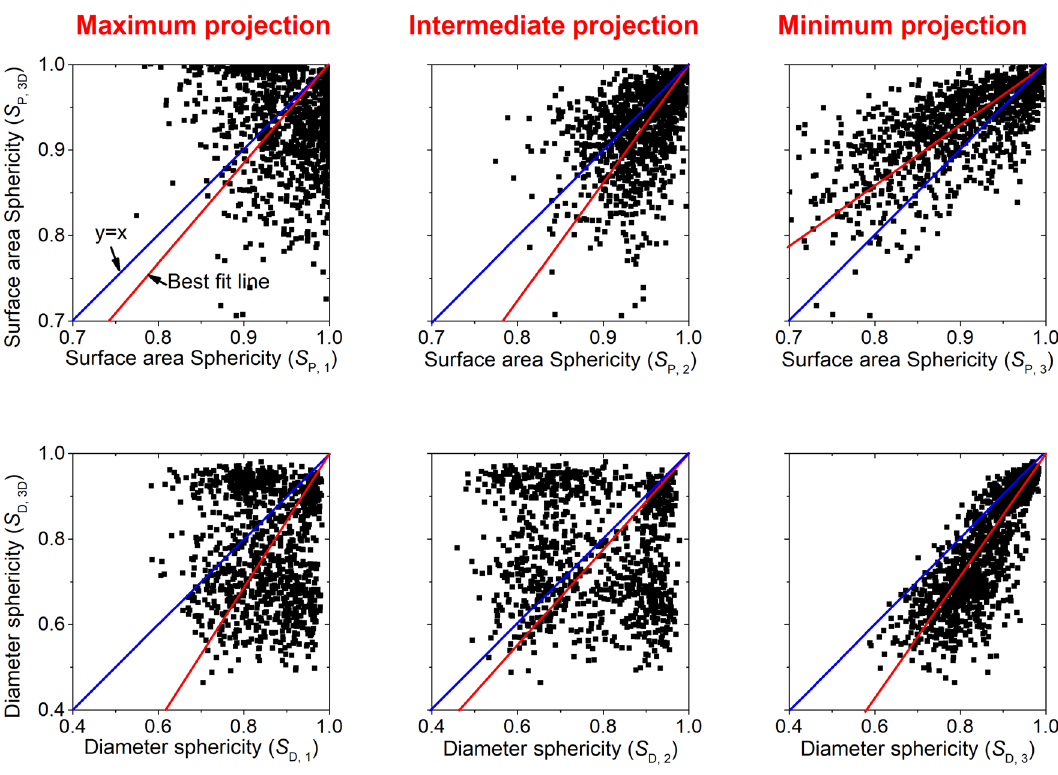
Fig. 12 Relationships between 2D vs. 3D diameter sphericity and surface area